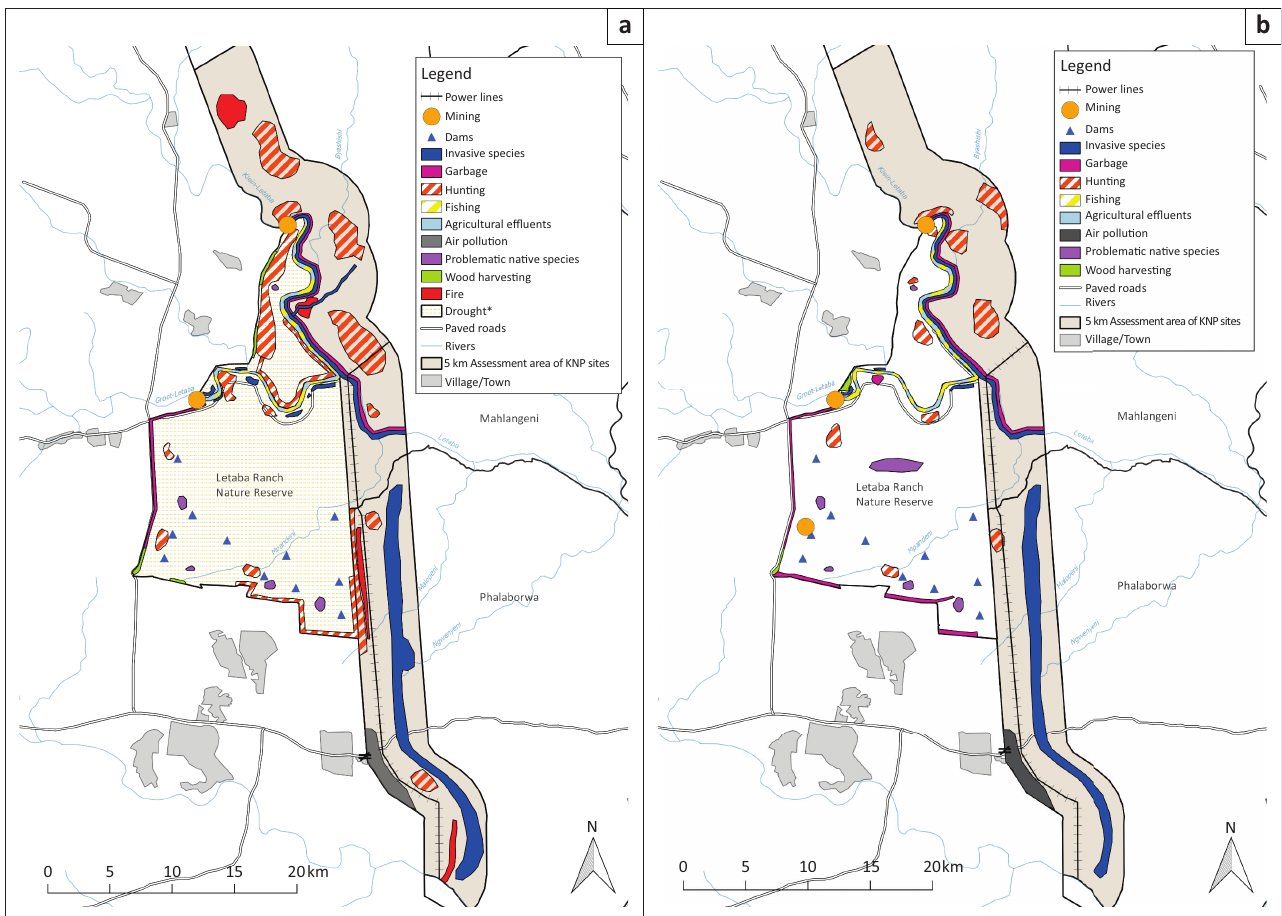
FIGURE 2: Spatial demarcation of threats to biodiversity in assessed areas in (a) 2013 and (b)